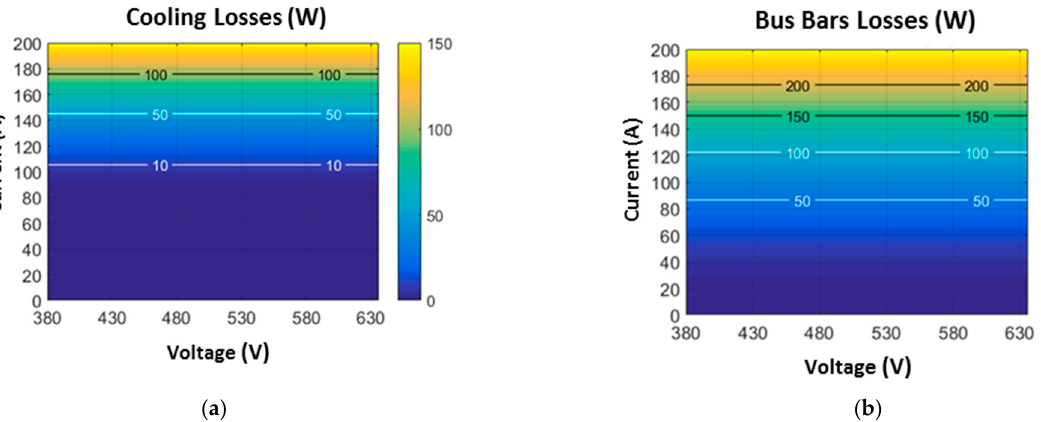
Figure 6. ( a ) Power losses map of the cooling system as a function of voltage and current and ( b ) power losses map in the connection bars between cells as a function of current and